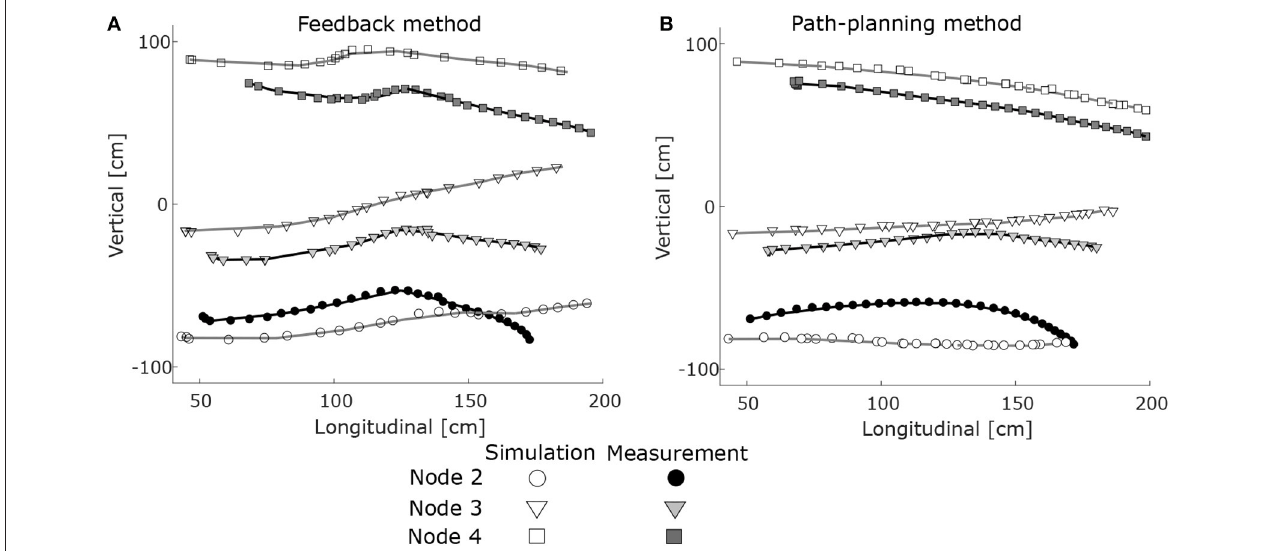
FIGURE 11 | End-node positions are shown from simulation and measurement of (A) the feedback method and (B) the path-planning method. Three end-nodes are shown.